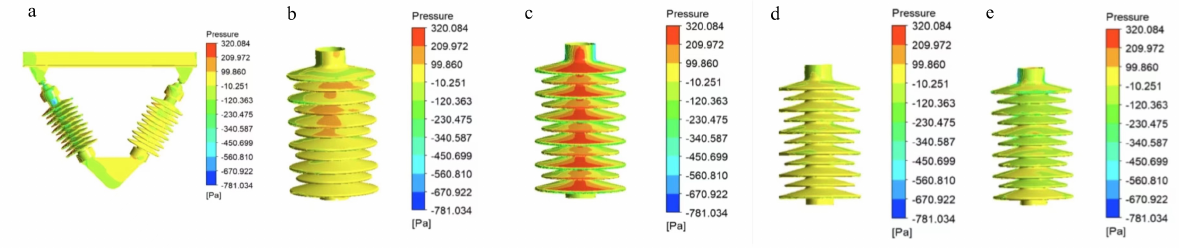
Figure 11. Static pressure distributions on the insulator surface under the wind speed of 20 m/s. ( a ) the surface pressure distributions on the crosswind side of insulators; ( b ) the surface pressure distributions on the windward surface of 2# insulator; ( c ) the surface pressure distributions on the windward surface of 1# insulator; ( d ) the surface pressure distributions on the leeward surface of 2# insulator; ( e ) the surface pressure distributions on the leeward surface of 1#